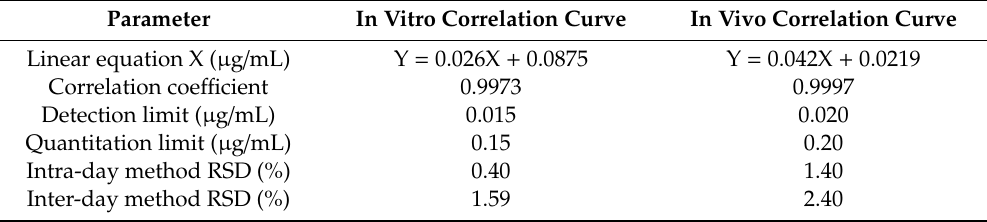
Table 2. Validation of non-exhaustive analytical method for CBZ quantitation. Parameter In Vitro Correlation Curve In Vivo Correlation Curve Linear equation X ( µ g / mL) Y = 0.026X + 0.0875 Y = 0.042X + 0.0219 Correlation coe ffi cient 0.9973 0.9997 Detection limit ( µ g / mL)